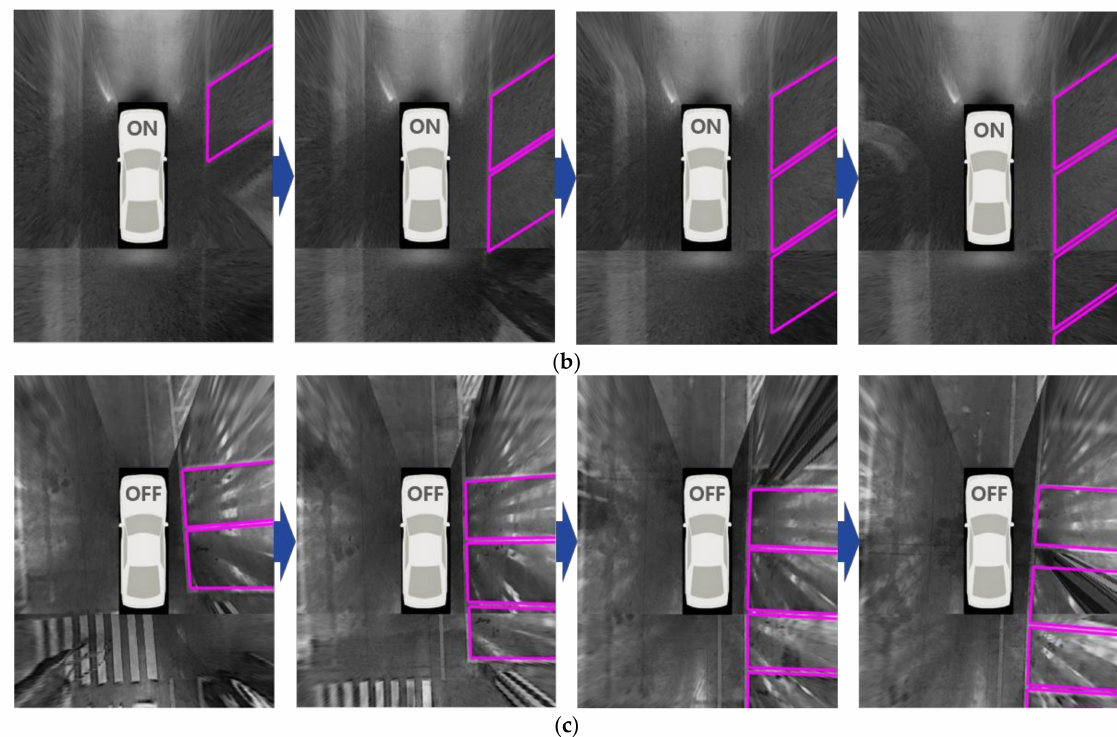
Figure 14. Parking slot recognition results of the proposed method in image sequences. ( a ) Daytime; ( b ) Nighttime; ( c )